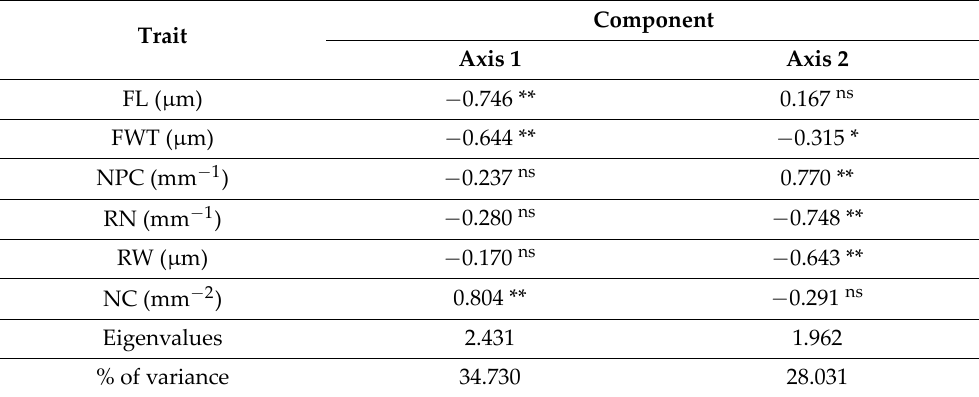
Table 2. Wood anatomical traits used in the principal component analysis (PCA) on sapwood of healthy and declined Quercus brantii affected by drought